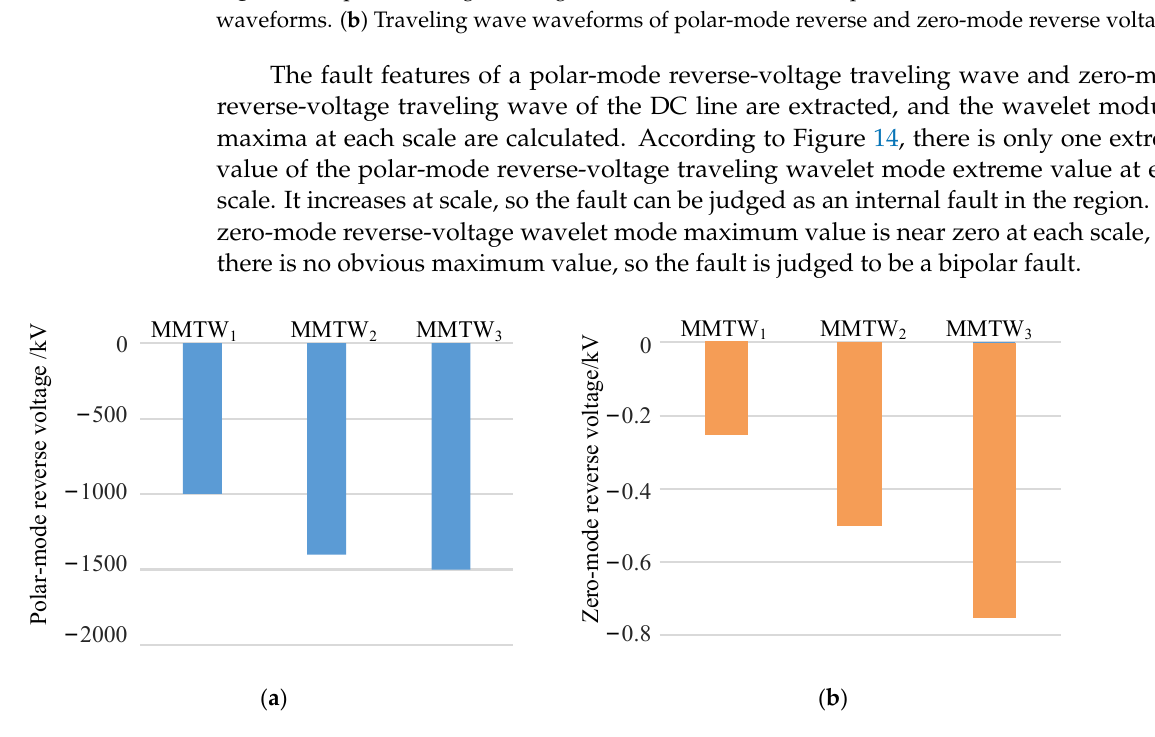
Figure 14. Wavelet transform results of maximum waveform in the bipolar metal short ‐ circuit fault signal. ( a ) Polar ‐ mode reverse ‐ voltage traveling wavelet mode maximum waveform; ( b ) \zero ‐ mode reverse ‐ voltage traveling wavelet mode extreme waveform.